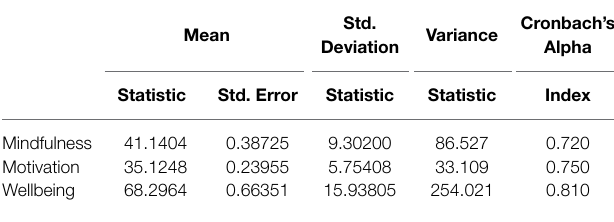
TABLE 1 | The reliability indices for the three questionnaires.